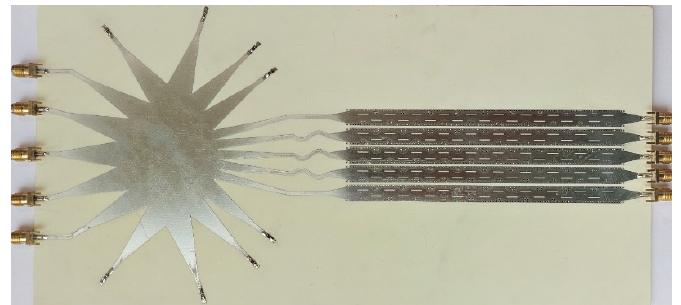
Figure 12. The prototype of the fabricated 2D-MBA.